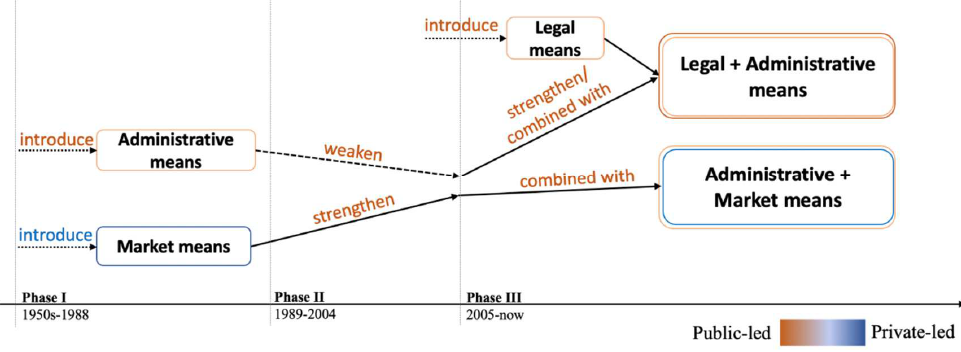
Figure 8. Changes of governance instruments in the MRN. Source: the authors.